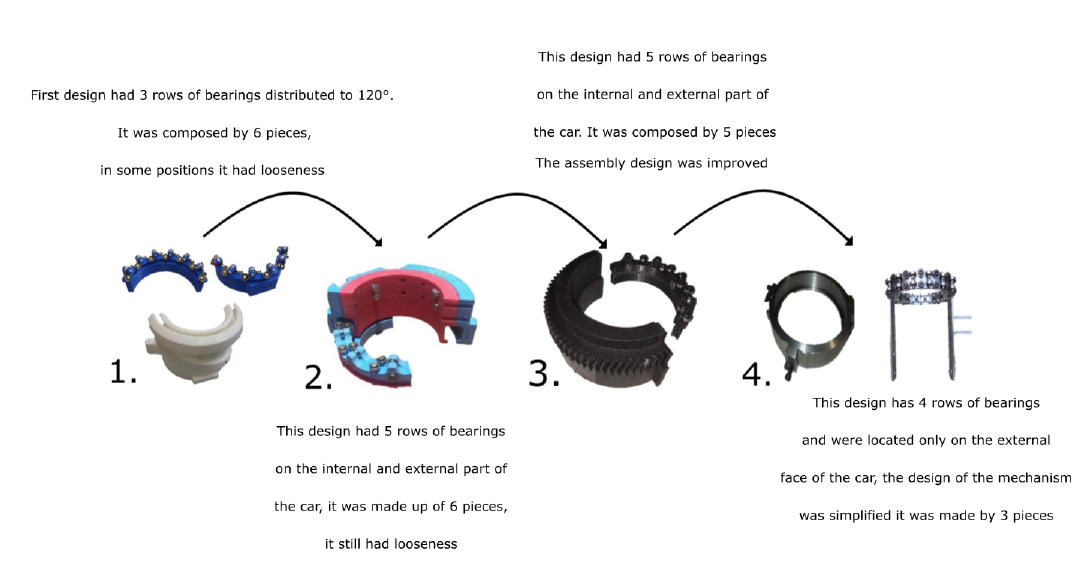
Figure 5. Increasing of (TRL) for the internal and external shoulder set.